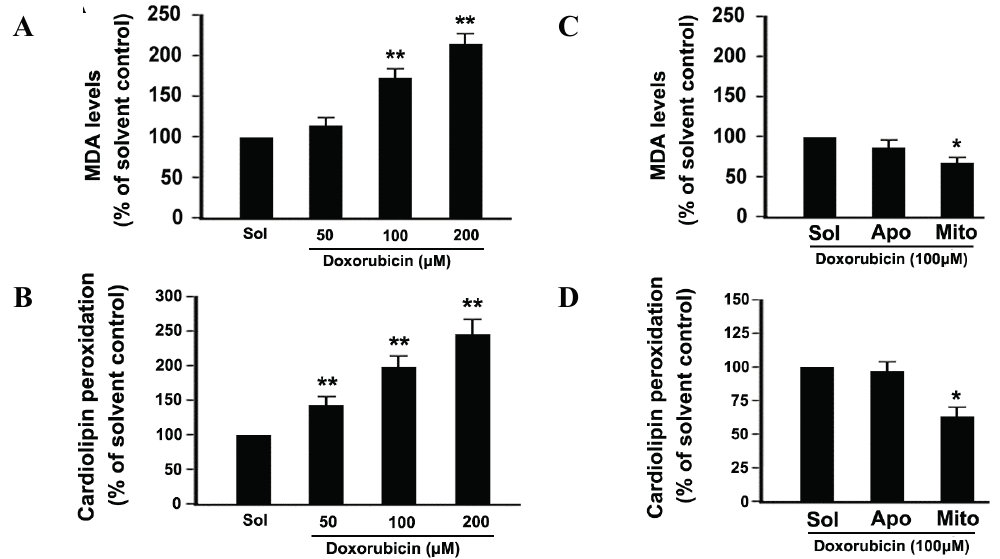
Figure 5. DOX increased malonyldialdehyde (MDA) production and cardiolipin peroxidation. ( A , B ) Platelets were incubated with different concentrations of DOX or solvent ( A ), or pre-incubated with apocynin, Mito-TEMPO, and then incubated with DOX ( B ). MDA levels were measured using an MDA assay kit. The MDA levels are expressed as a percentage of platelets that were incubated with solvent; ( C , D ) Platelets were incubated with different concentrations of DOX or solvent ( C ), or pre-incubated with apocynin, Mito-TEMPO, and then incubated with DOX ( D ). Cardiolipin peoxidation was detected as described in Methods. Data are expressed as a percentage of platelets that were incubated with solvent. Percentage is presented as means ± SEM from three independent experiments. ** p < 0.017 (after Bonferroni correction) as compared with solvent. * p < 0.025 (after Bonferroni correction) as compared with solvent control. Solvent, apocynin and Mito-TEMPO and are labeled as Sol, Apo and Mito,